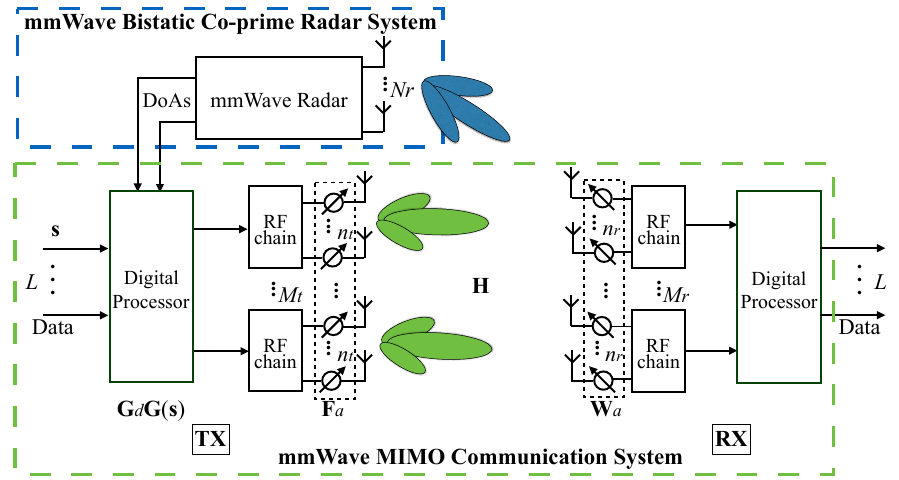
Figure 1. Block diagram of the radar aided mmWave communication